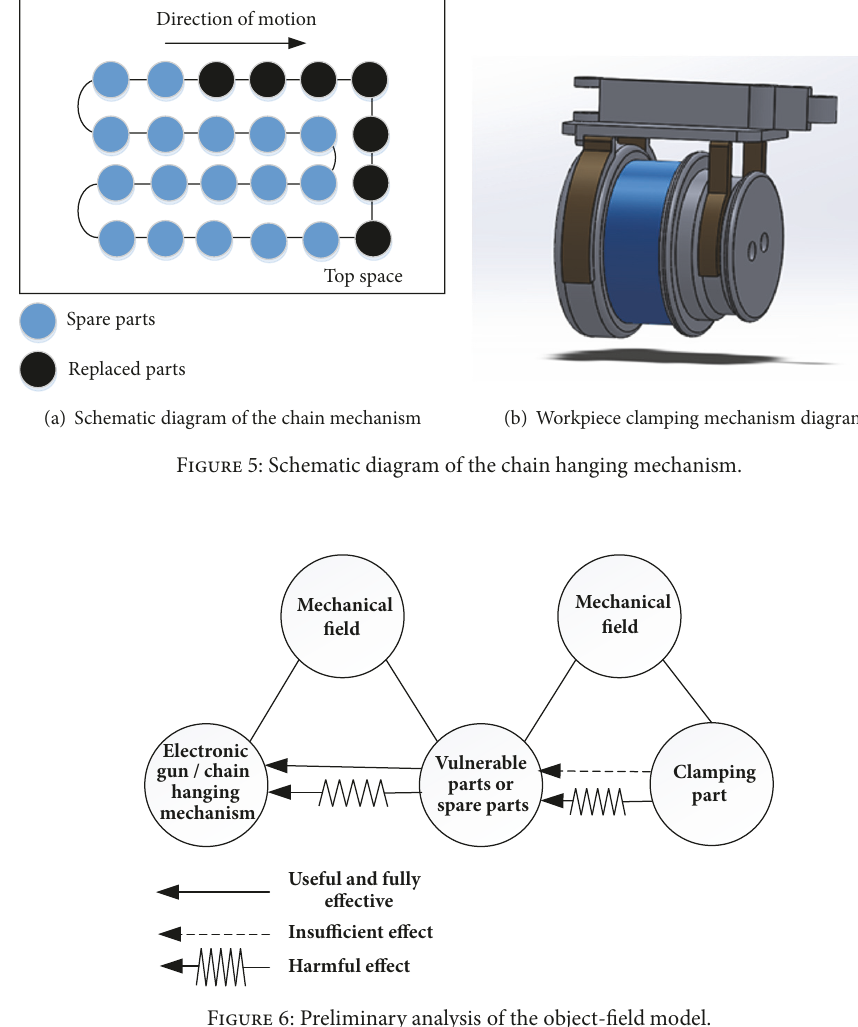
Figure 6: Preliminary analysis of the object-field model.